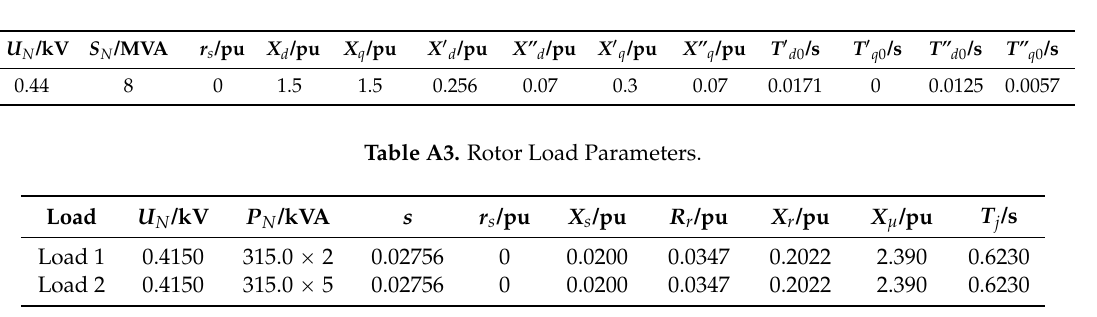
Table A2. Gas Turbine Parameters.